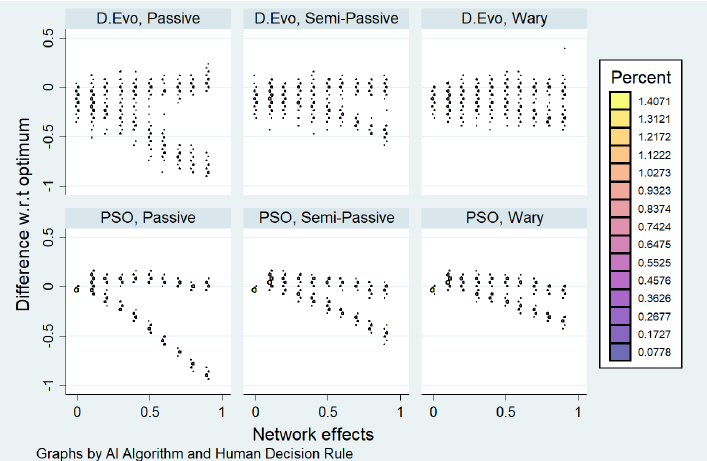
Figure 6. Price estimation error. Source: